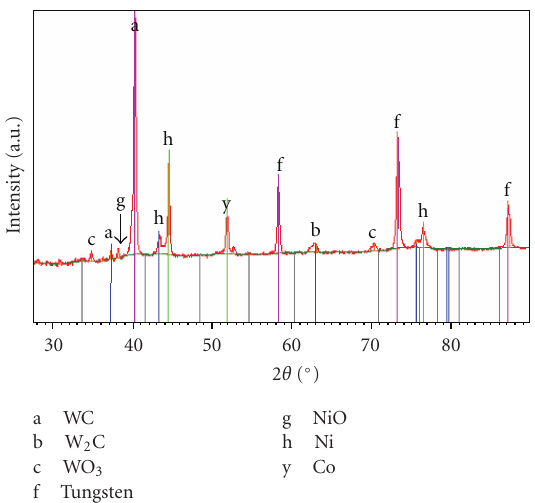
Figure 5: X-ray di ff raction pattern of WC-17Co coatings sprayed with SD 350mm.